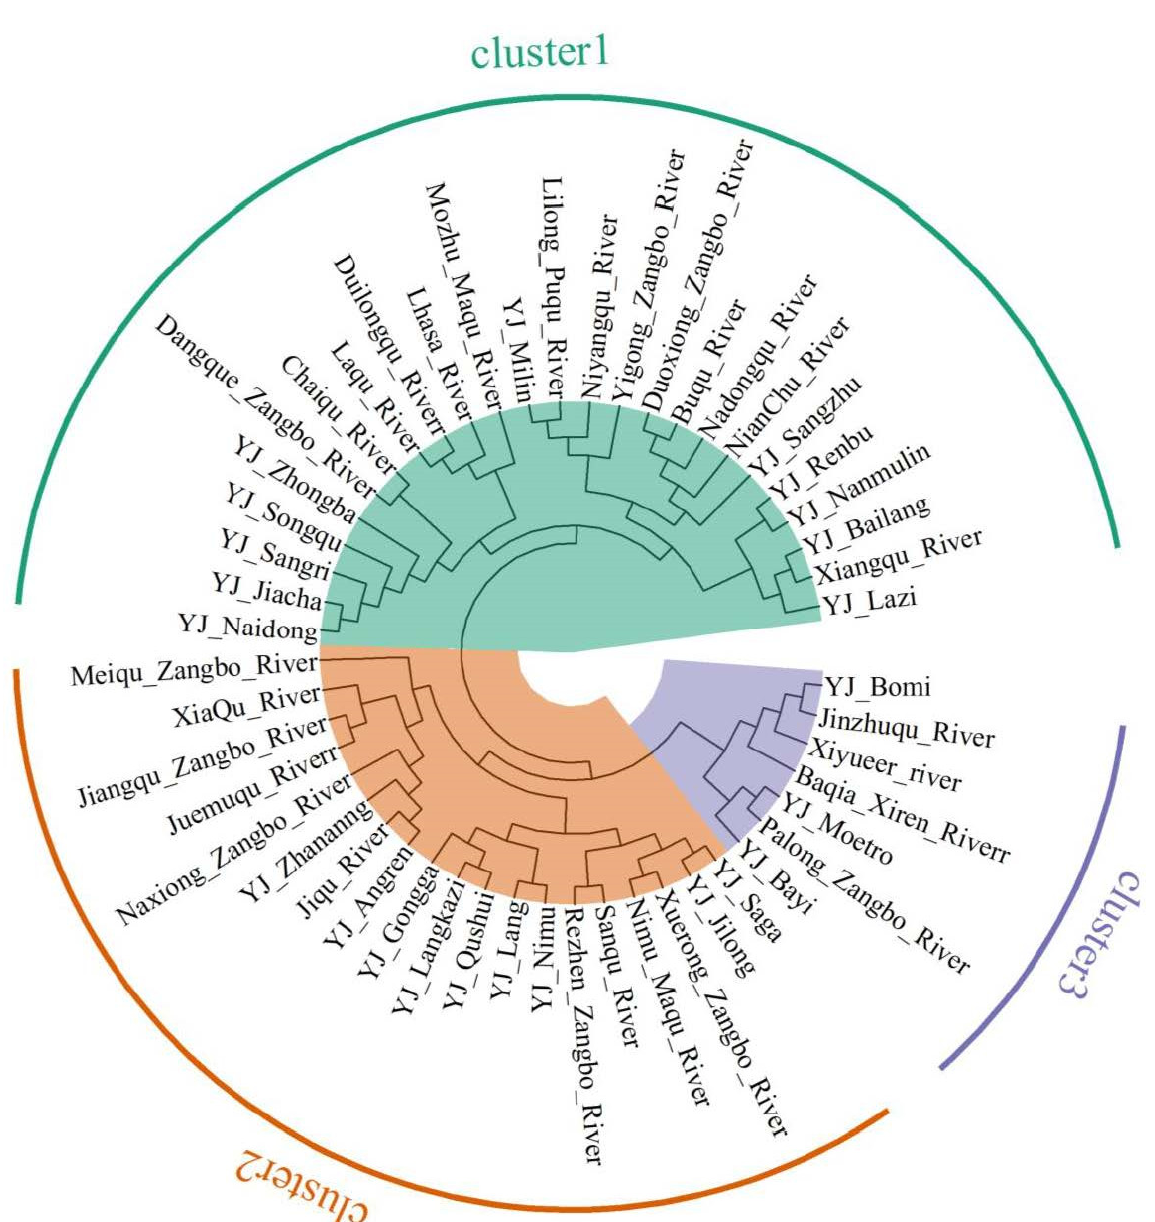
Figure 3. Ward clustering for native fish in the Yarlung Zangbo River Basin showing 3 main groups (clusters 1–3). Code for different mainstream locations in the Yarlung Zangbo River: (1) “YJ” is the code name for “Yarlung Zangbo River”; (2) the names of the counties where different sections of the Yarlung Zangbo River are located after “YJ”, such as “YJ_Lazi”, mean that the Yarlung Zangbo River section is in Lazi County, etc.